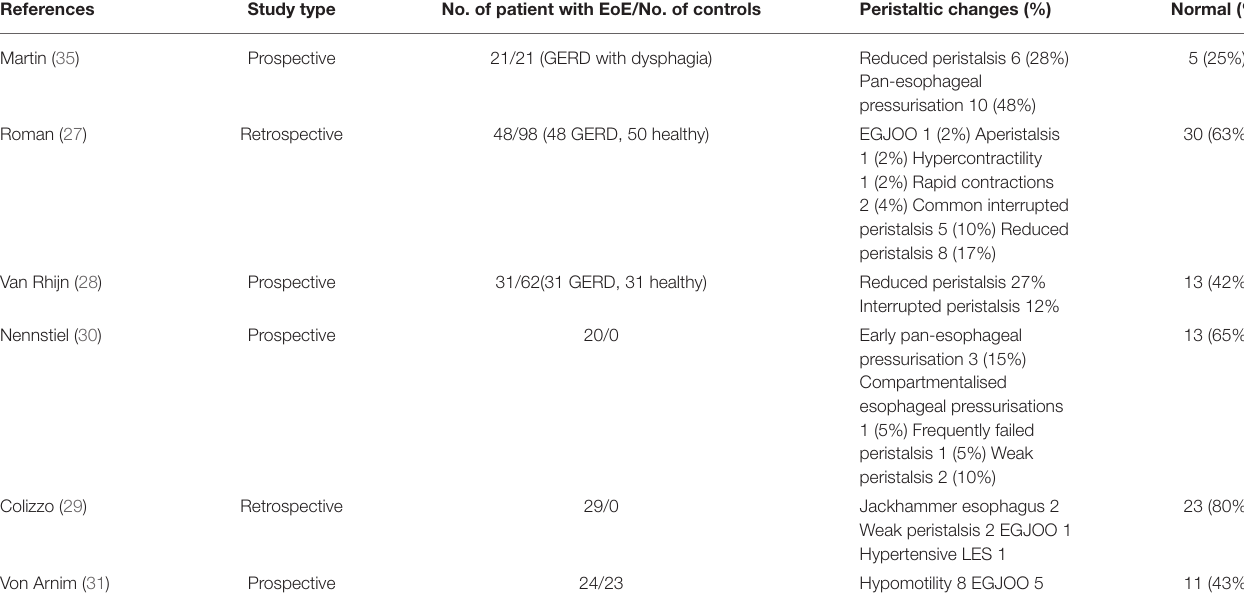
TABLE 2 | High resolution manometry studies in eosinophilic